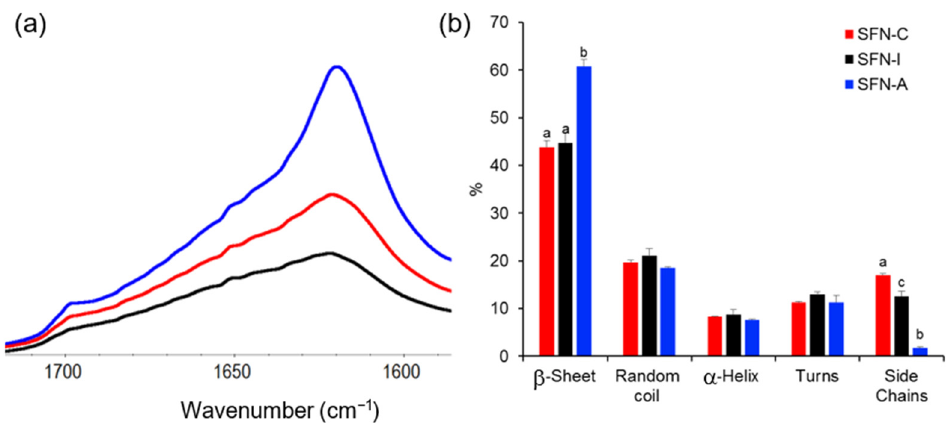
Figure 2. ATR-FTIR analysis of the secondary structure of the silk fibroin nanoparticles. ( a ) amide I region of the ATR-FTIR spectra of non-sterilized (SFN-C, red), gamma irradiated at 5 kGy (SFN-I, black), and autoclaved (SFN-A, blue) SFNs; ( b ) Secondary structure assignation obtained by Fourier self-deconvolution of the amide I peak. Different letters in the same group indicate significantly different subsets ( p < 0.05).